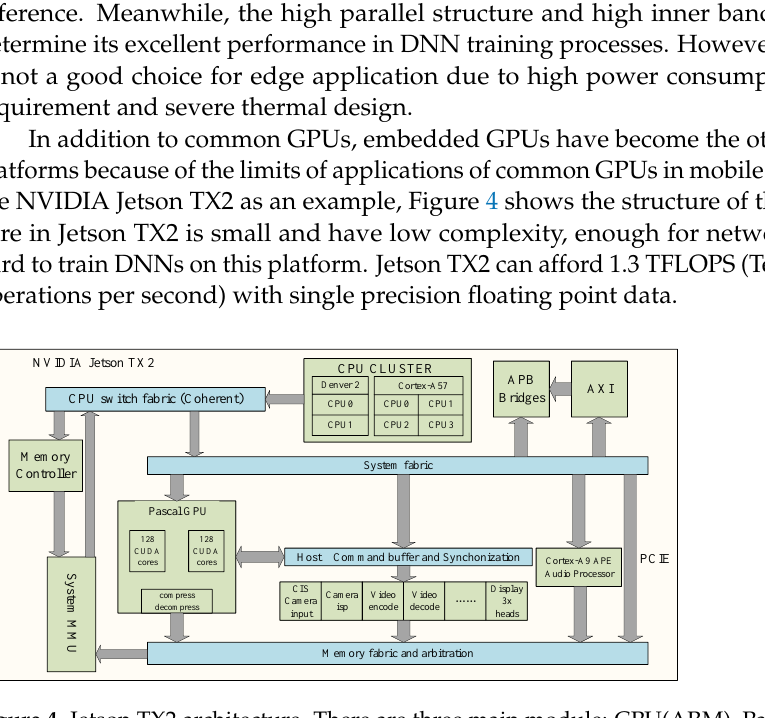
Figure 4. Jetson TX2 architecture. There are three main module: CPU(ARM), Pascal GPU, Memory. Computing is operated on CUDA